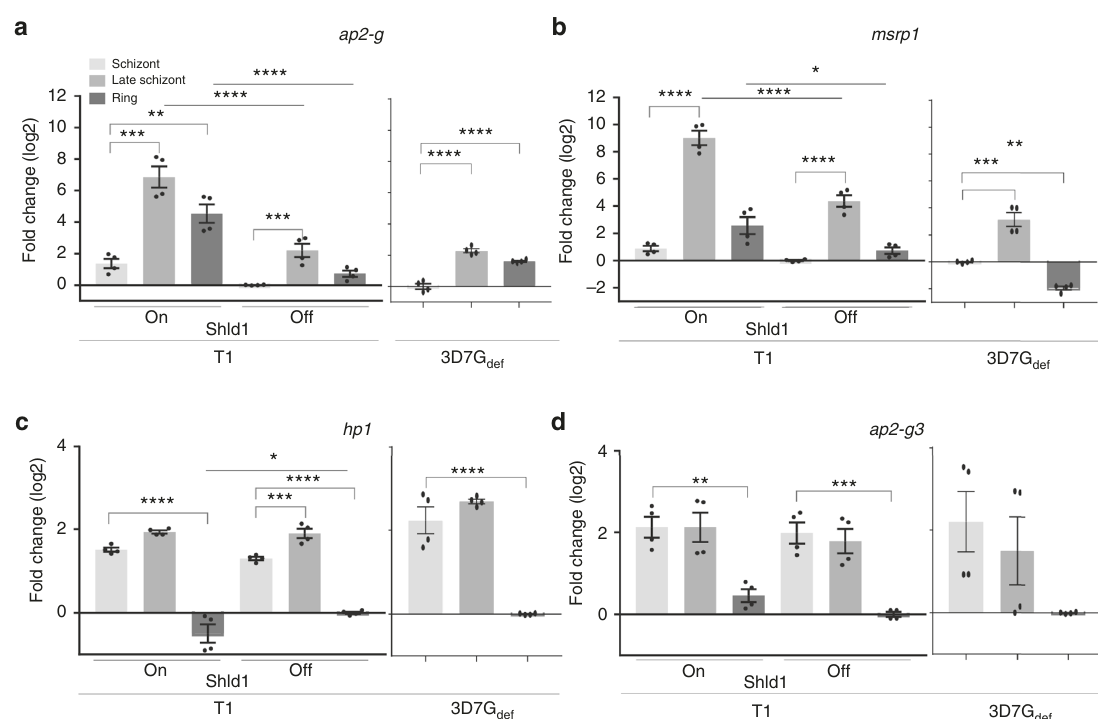
Fig. 8 Gene expression patterns in the absence of GDV1. The fold change (2 − ΔΔ C T ) of ap2 - g a , msrp1 b hp1 c , and ap2 - g3 d RNA levels was tested in early schizonts (36 ± 2 hpi) (light grey), late schizonts (46 ± 2 hpi) (medium grey) and 12 ± 2 h later in ring stage parasites (dark grey) in Pfgdv1.gfp.dd .T1 parasites in the absence (Off) and presence (On) of Shld1 ( a – d ) as well as the clonal 3D7.G def parasite line that lacks the gdv1 locus due to a spontaneous chromosome 9 deletion 24 . Expression levels in early schizonts in the absence of Shld1 are used as the reference for ap2-g a and msrp1 b , while the Shld1 minus ring stage expression levels were used for hp1 c and ap2-g3 d . The data are from 2 independent experiments performed in duplicate. To compare expression between stages and conditions in the Pfgdv1.gf.dd parasite line a two-way ANOVA with Sidak ’ s multiple comparisons test was used. For the 3D7.G def line, a one-way ANOVA with Dunnett ’ s multiple comparisons test was performed to compare expression between stages. For both analyses a Bonferroni post-hoc test to correct for the analysis of 4 genes was used and probability is indicated, p ≤ 0.05 (*), p ≤ 0.01 (**), p ≤ 0.001